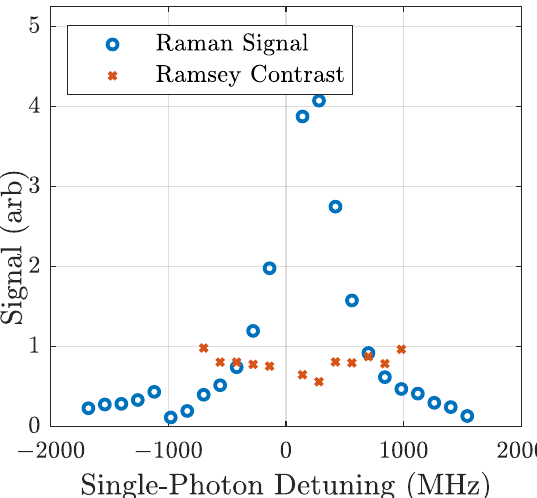
Figure 14. Experimentally measured Raman signal above background data points (blue circles) and Ramsey contrast (red crosses) as a function of